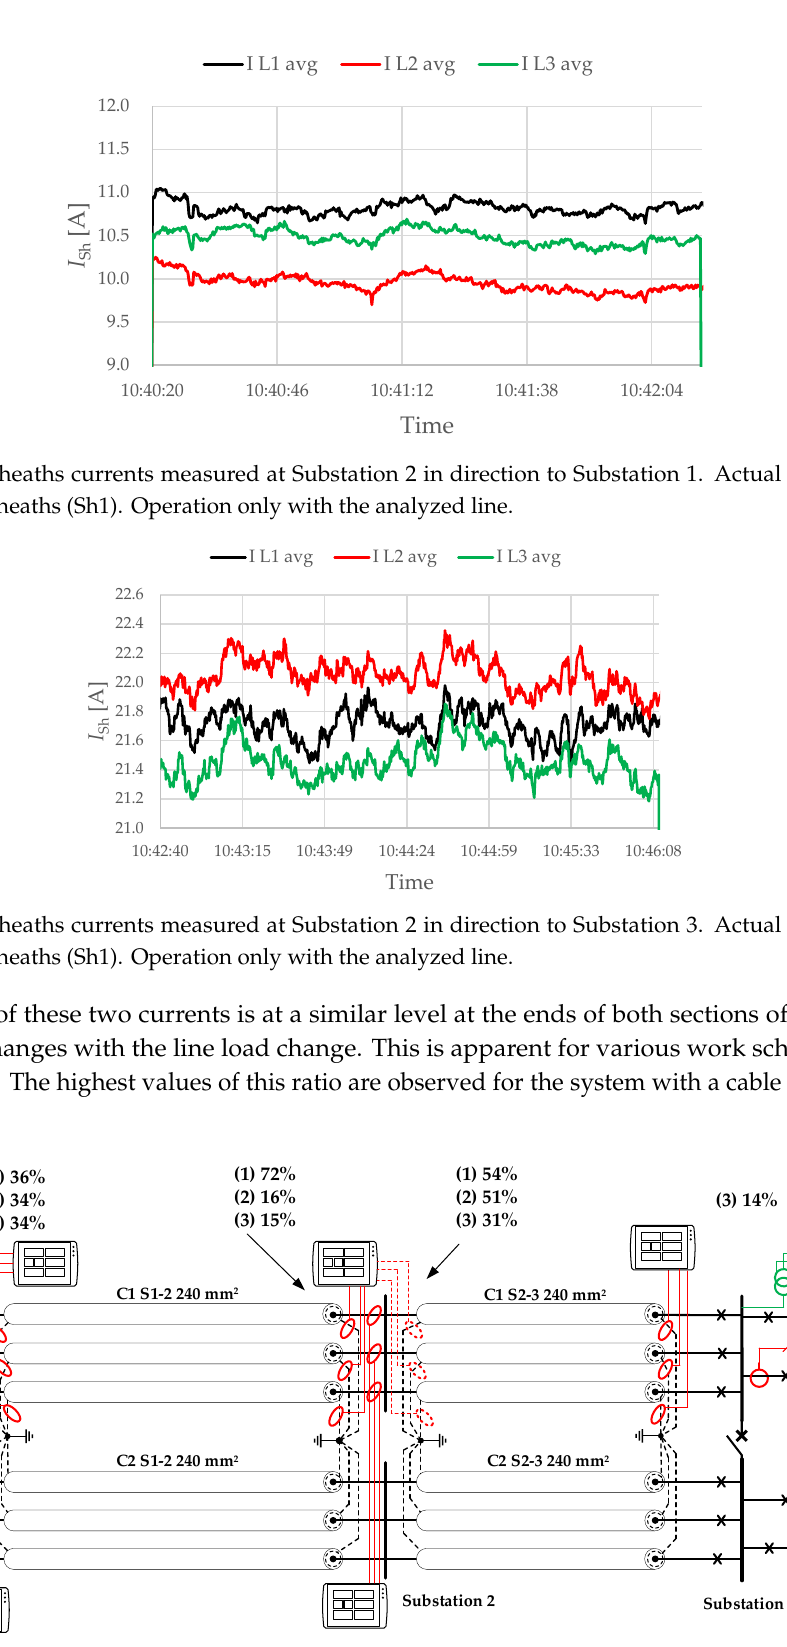
Figure 9. Percentage share of sheaths currents related to cores currents for three cable line work systems: ( 1 ) one-sided power supply of the line, ( 2 ) parallel operation of both cable lines, ( 3 ) operation only with the analyzed line.